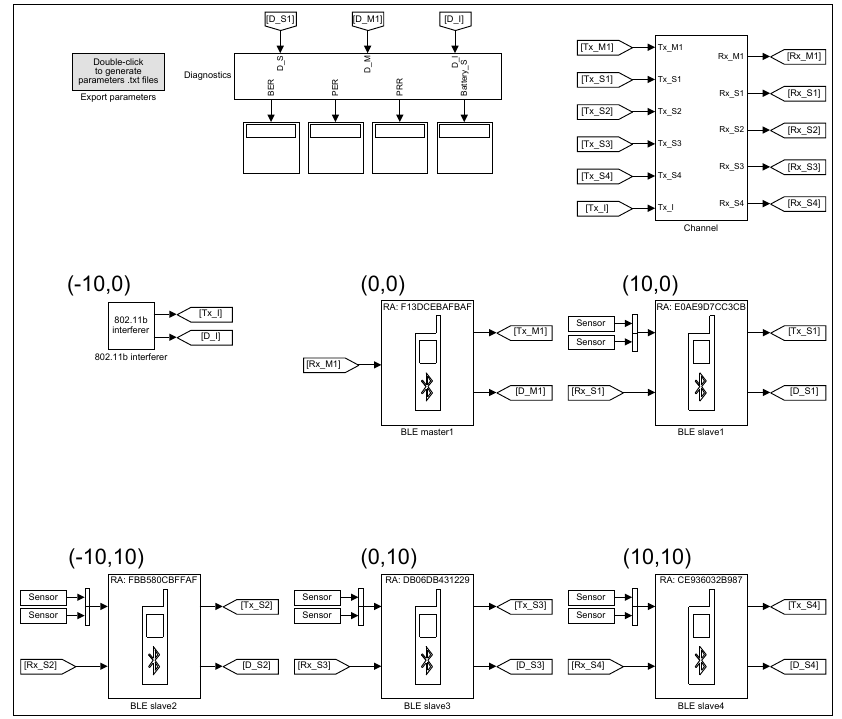
Figure 18. The model M 1S4 consisting of one master device (in multiple slaves mode), four slaves and the